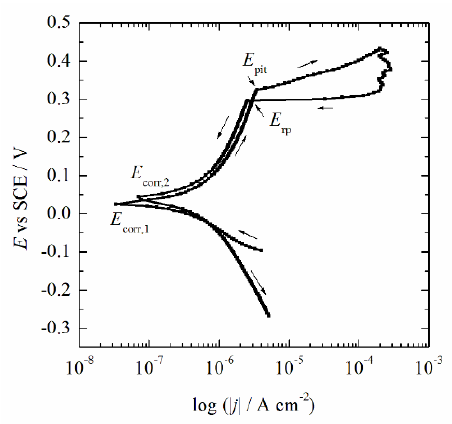
Figure 8. Initial polarization curve ( v = 1 mV s − 1 ) of the stainless still 316Ti alloy after 1 h of immer- sion in 0.9 wt.% NaCl.